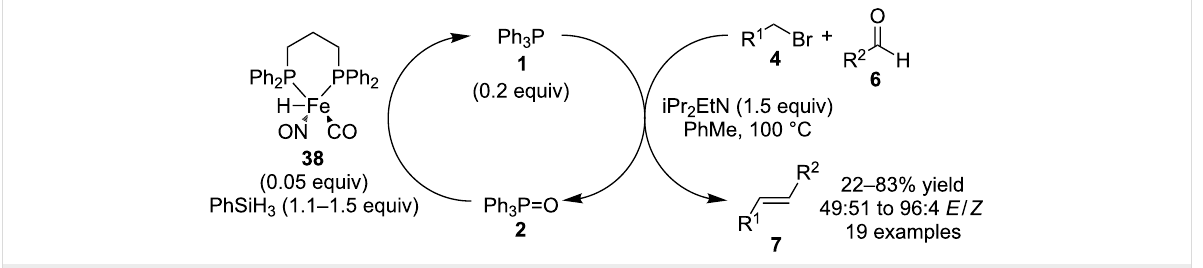
Scheme 11: Catalytic Wittig reactions reported by Plietker.